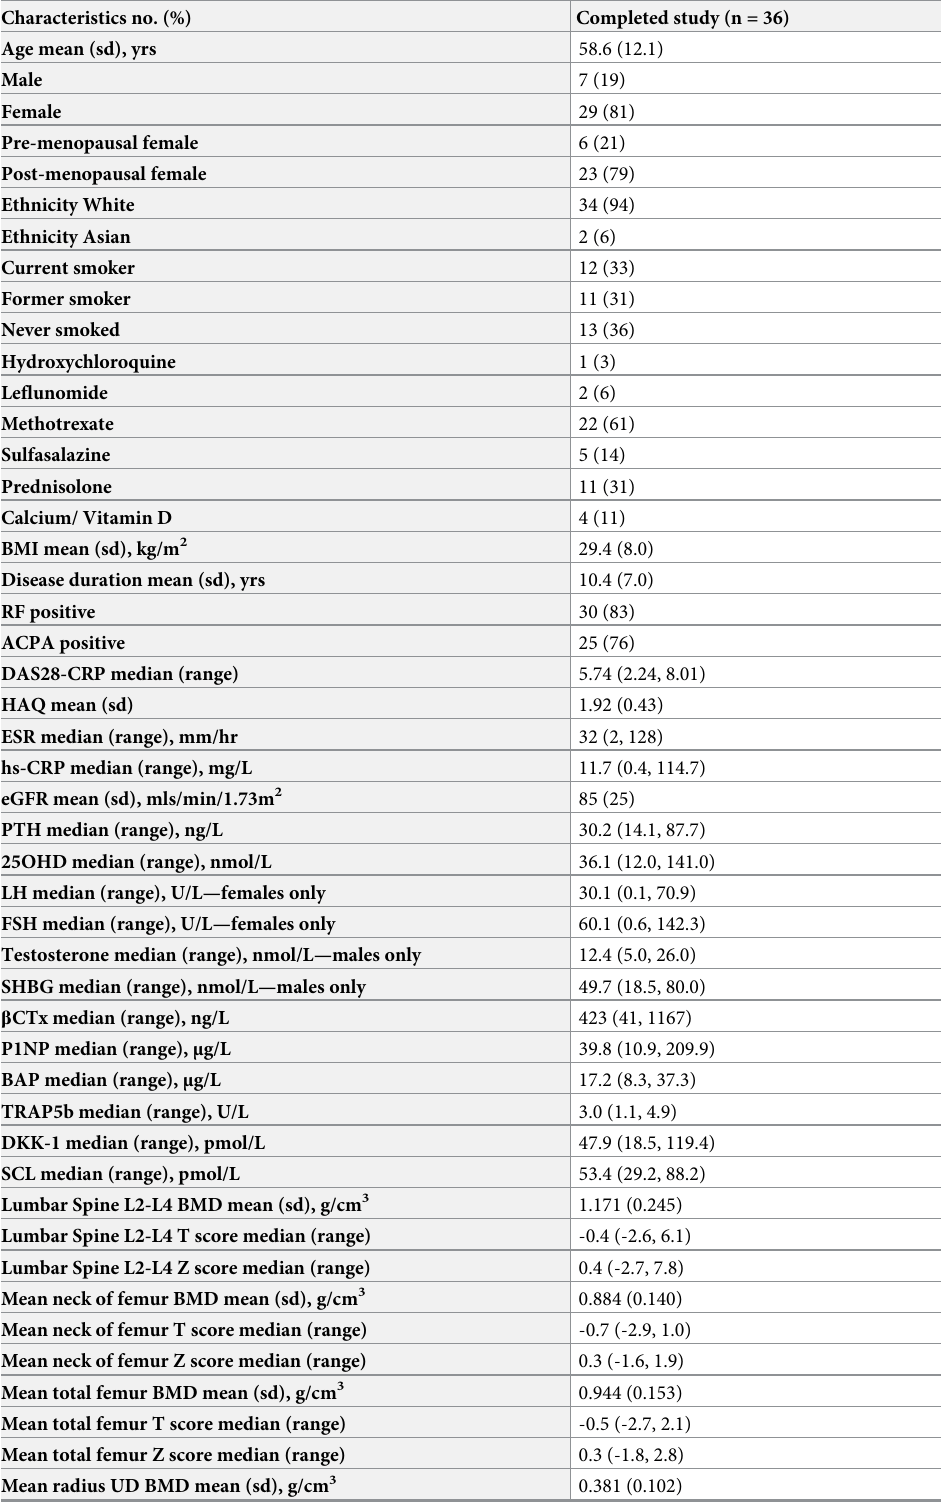
Table 1. Baseline characteristics of the study patients. Characteristics no.